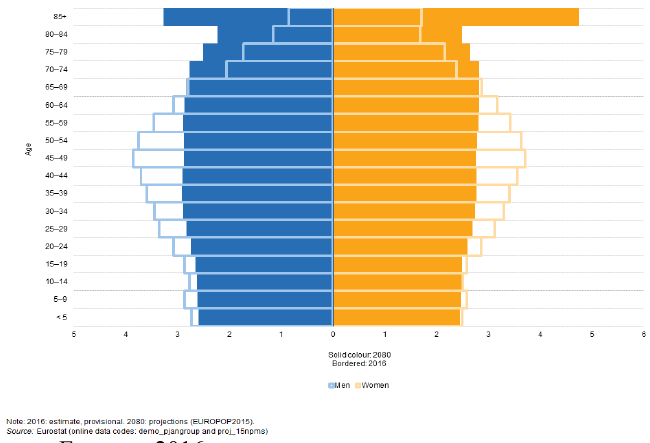
Source: Eurostat, 2016